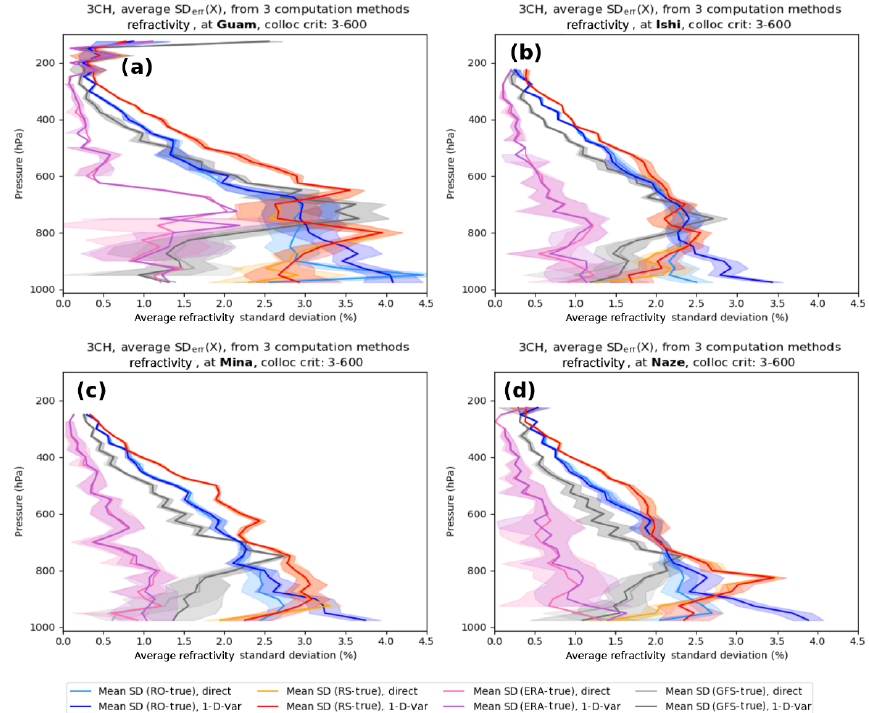
Figure B4. Mean and standard deviations (shading) of the three estimates of normalized refractivity using RO-direct and RO 1D-VAR at (a) Guam, (b) Ishi, (c) Mina, and (d)